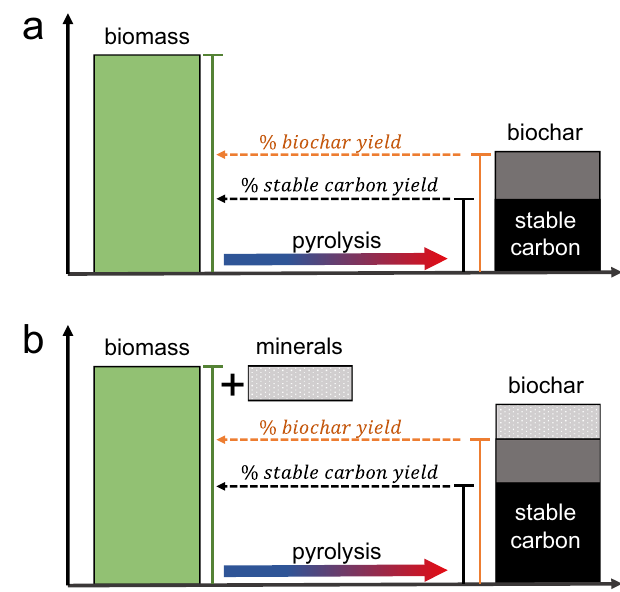
Fig. 1 Graphical representation of biochar stable carbon yield. a Biochar stable carbon yield (%) based on biochar yield (% conversion of biomass into biochar) and stable carbon content within biochar (%) and b enhanced stable carbon formation from the same amount of biomass through mineral doping prior to pyrolysis. Following equations are used to calculate the biochar stable carbon yield: (1) biochar yield (%) = amount biochar/ amount biomass; (2) biochar stable carbon content (%) = amount stable carbon/amount biochar; (3) stable carbon yield (%) = biochar yield (%) * biochar stable carbon content